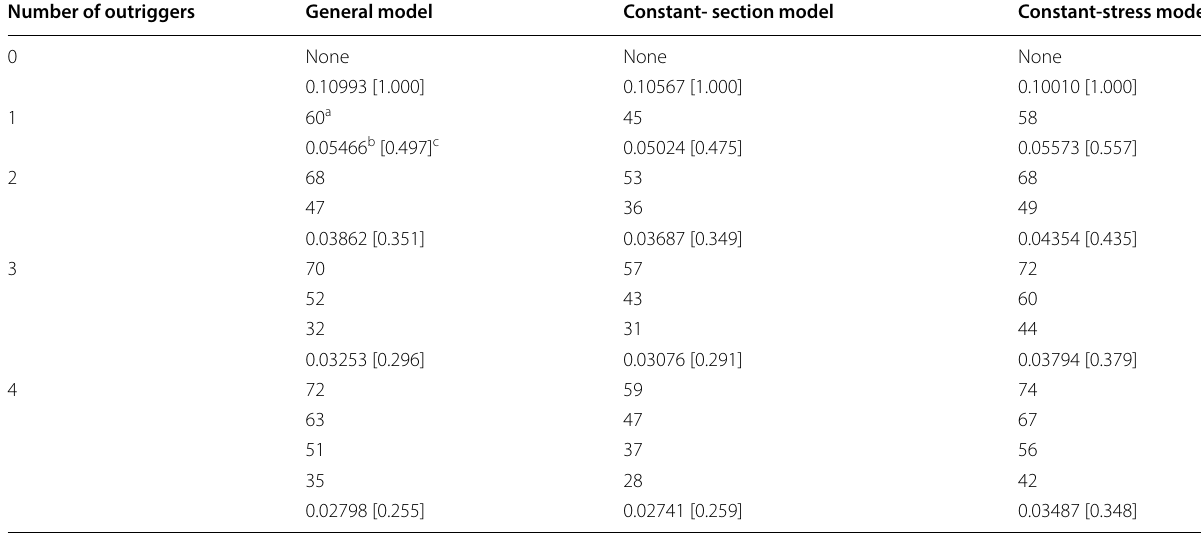
Table 3 Optimum locations and maximum DAS with the constant-area scheme.